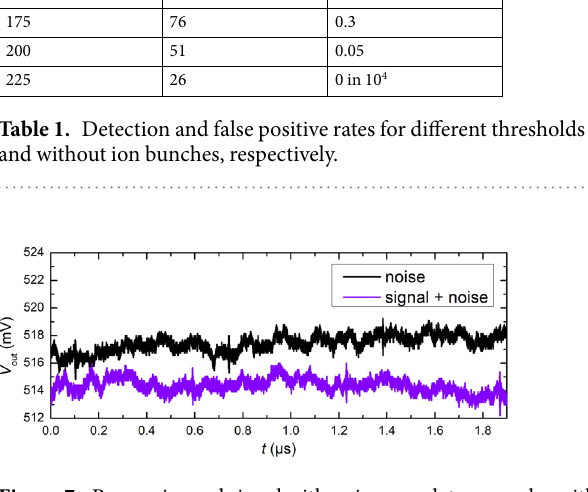
Figure 7. Pure noise and signal with noise; raw data examples without acquisition averaging. The rms noise level is approx. 600 µ V, corresponding to 1200 e . Switching interferences are chosen to lie outside (before) the region of interest.